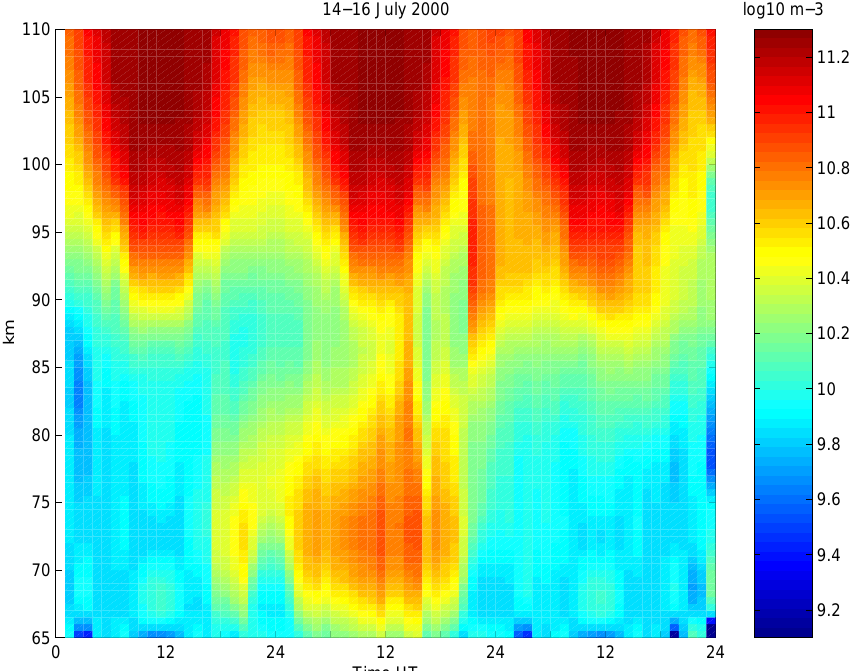
Fig. 2. Total electron number density from 14–16 July